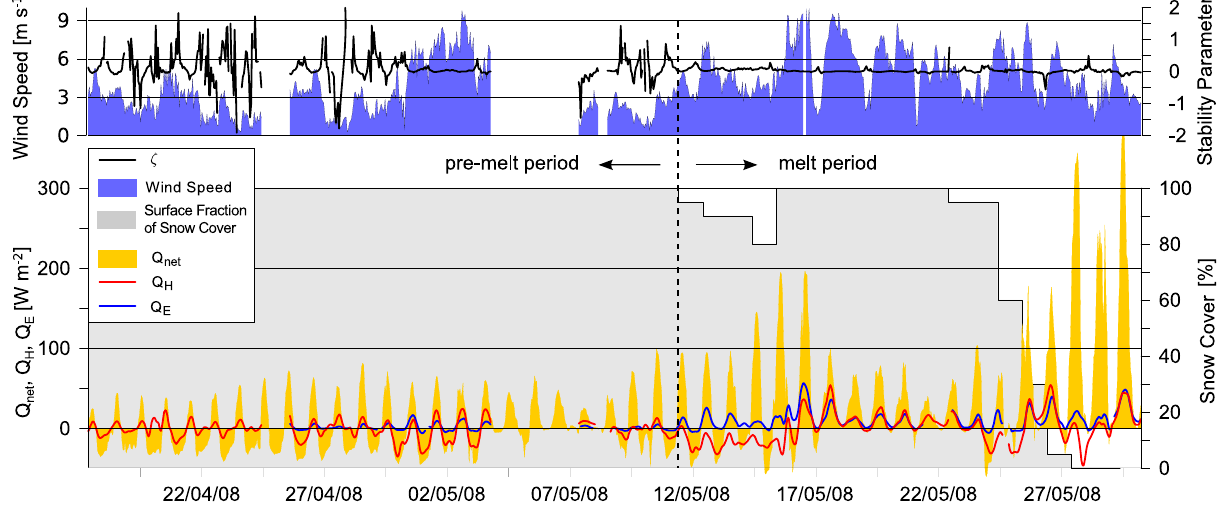
Fig. 4. Net radiation, sensible heat flux, latent heat flux, wind speed, atmospheric stability parameter ζ , and approximate fraction of the snow-covered area (in gray) during spring 2008. The energy balance is strongly related to the evolution of the snow melt. Wind speed increases during the melt period, and atmospheric stratification is neutral. Varying atmospheric conditions are observed in the pre-melt